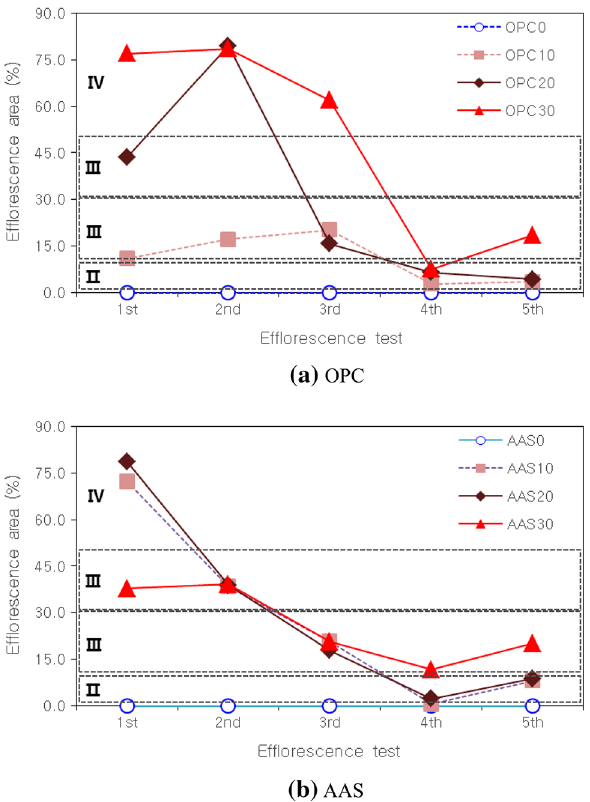
Fig. 10 Efflorescence area with the number of